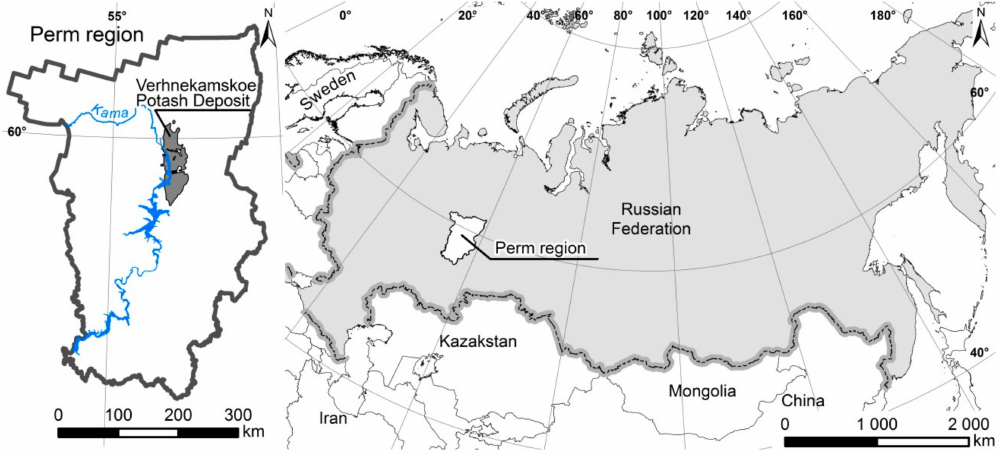
Figure 1. Geographical location of the Verkhnekamskoe potash